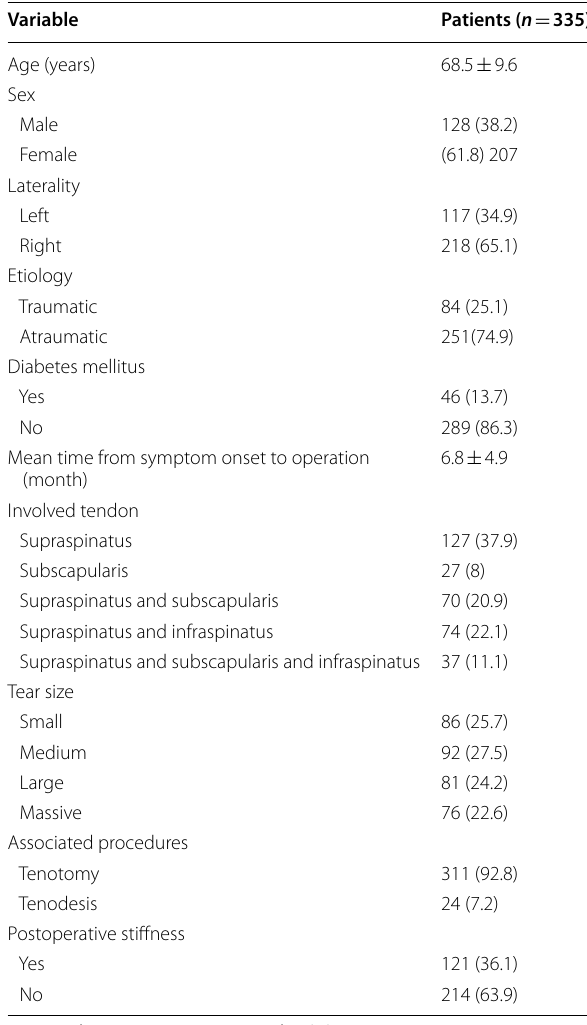
Table 1 Characteristic features of the patients who underwent arthroscopic repair for rotator cuff